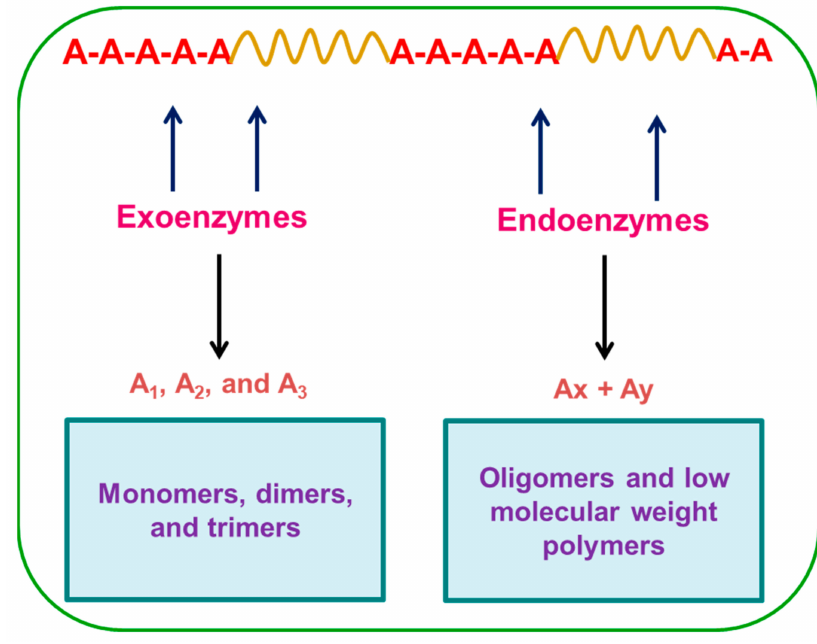
Figure 5. Enzyme-catalyzed degradation processes. Table 2. Enzymatic activity of Xylaria isolates in biodegradation